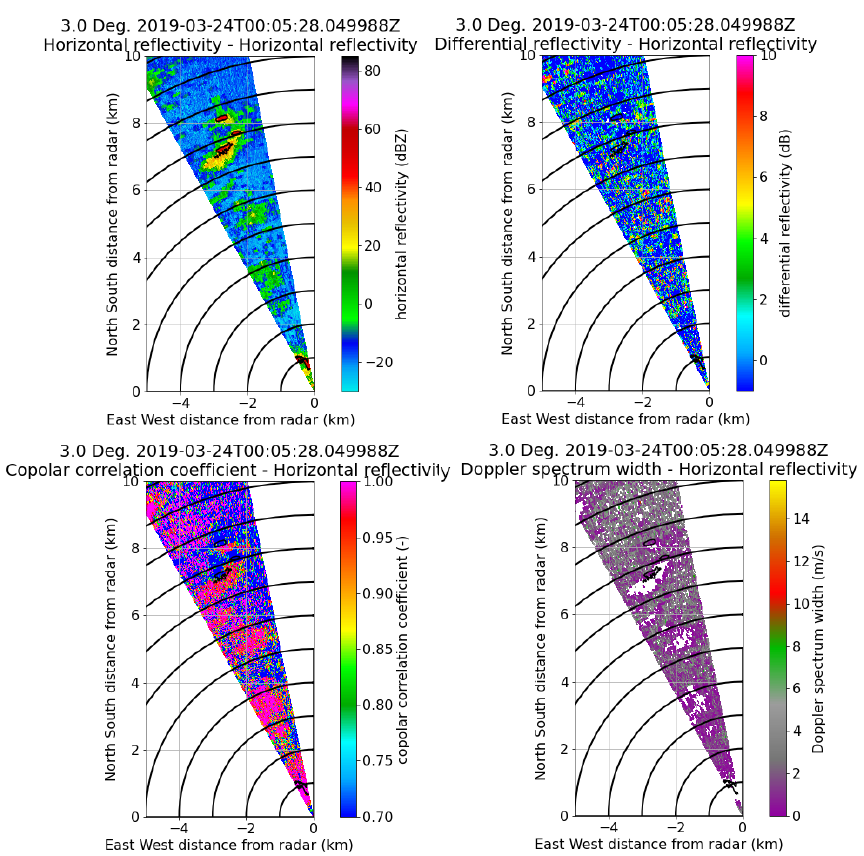
Figure 4. Example of single PPI slices (a–d) of horizontal reflectivity Z H , differential reflectivity Z DR , co-polar correlation coefficient ρ HV and Doppler spectrum width W covering the wind park of the three wind turbines at an elevation angle of 3 ◦ on 24 March 2019. The black circles indicate a range spacing of 1km. In all PPI slices the 35dBZ reflectivity contour is drawn to show the approximate location of the three wind turbine scatterers. Table 5. Conversion factors F to obtain the radar cross-section (RCS) from Z H for the three wind turbines WT1, WT2 and